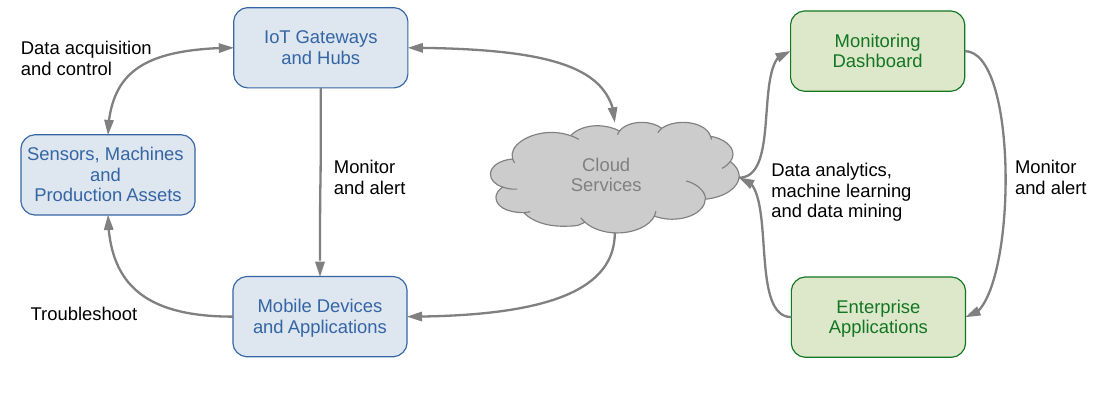
Figure 1. Big Data analytics and security intelligence for Industry 4.0